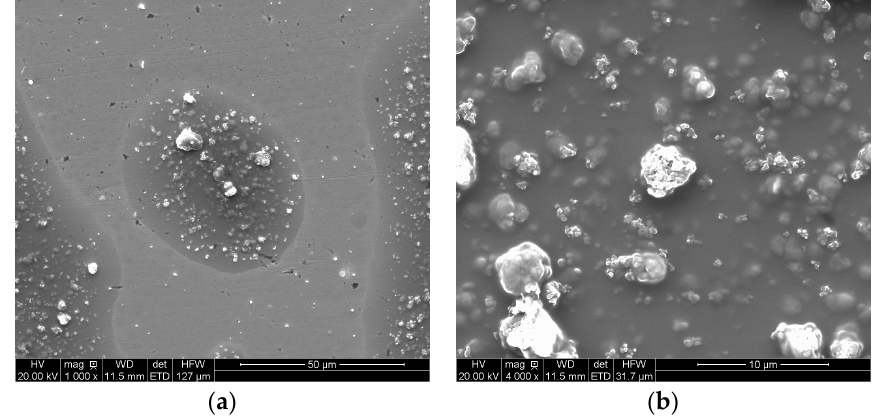
Figure 2. Cross-sectional structure of coatings fabricated using 5% PAA ( a ) and 8% PAA ( b ).